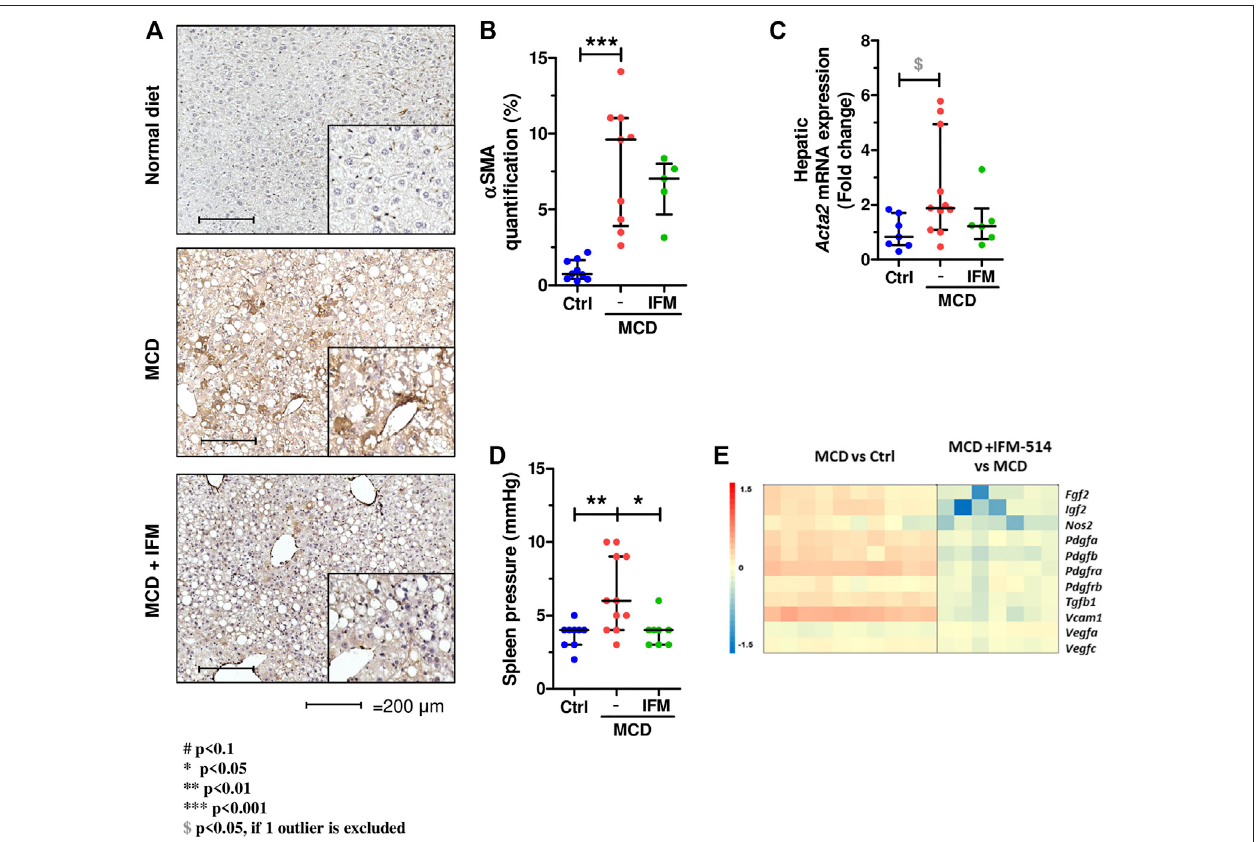
FIGURE5| HepaticstellatecellactivationinMCD-fed ApoE -/- mice. α -smoothmuscleactinimmunostaining (A) withquanti fi cation (B) fromIFM-514-treatedMCD- fed ApoE -/- mice. Acta2 mRNA expression (C) . Spleen pressure analyses (D). Heatmap for portal hypertension set of genes (E). All mRNA data were normalized to the expressionof 18s .Resultsareexpressedasmean ± standarderrorofthemean(SEM);n (cid:1) 10/group,# p < 0.1,* p < 0.05,** p < 0.01and*** p < 0.001. $ p < 0.05,ifoutliers are excluded. Scale bars (cid:1) 200 μ m. Abbreviations: CV, central vein; PV, portal vein; acta2, α -smooth muscle actin gene; α SMA, α -smooth muscle actin. See Supplementary Table 3 for Heatmap